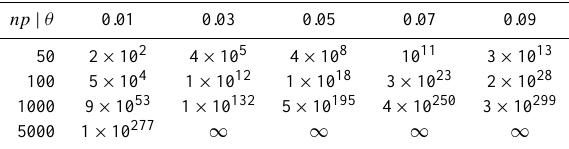
Table 2. Complexity as a function of θ and the matrix dimension np . Infinity symbols denote numbers that exceed machine